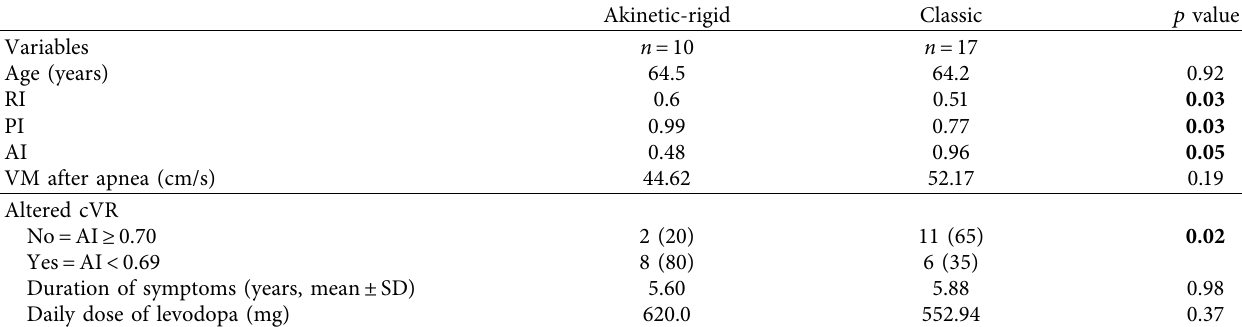
Table 1: Comparison between groups of Parkinson’s disease phenotypes (akinetic-rigid x classic).